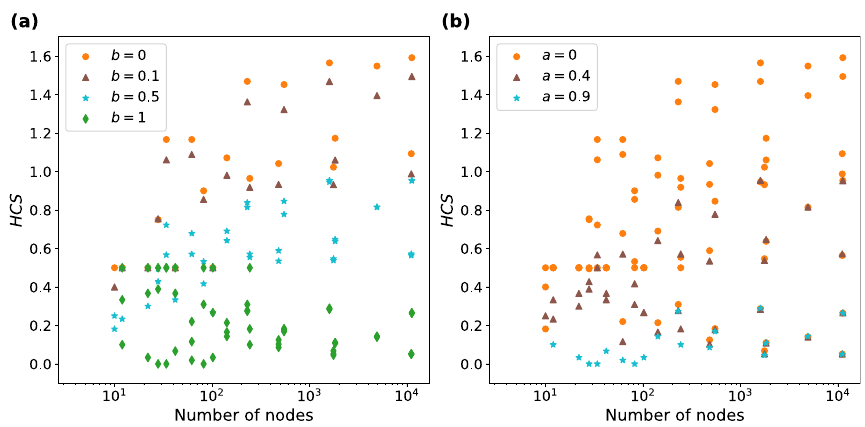
Fig. 16 Plots of the hub connectivity score for the HADG model. HCS is plotted against the logarithm of the number of nodes. The grouping of points is based on a parameter b , which influences fractality, b parameter a , which influences hub